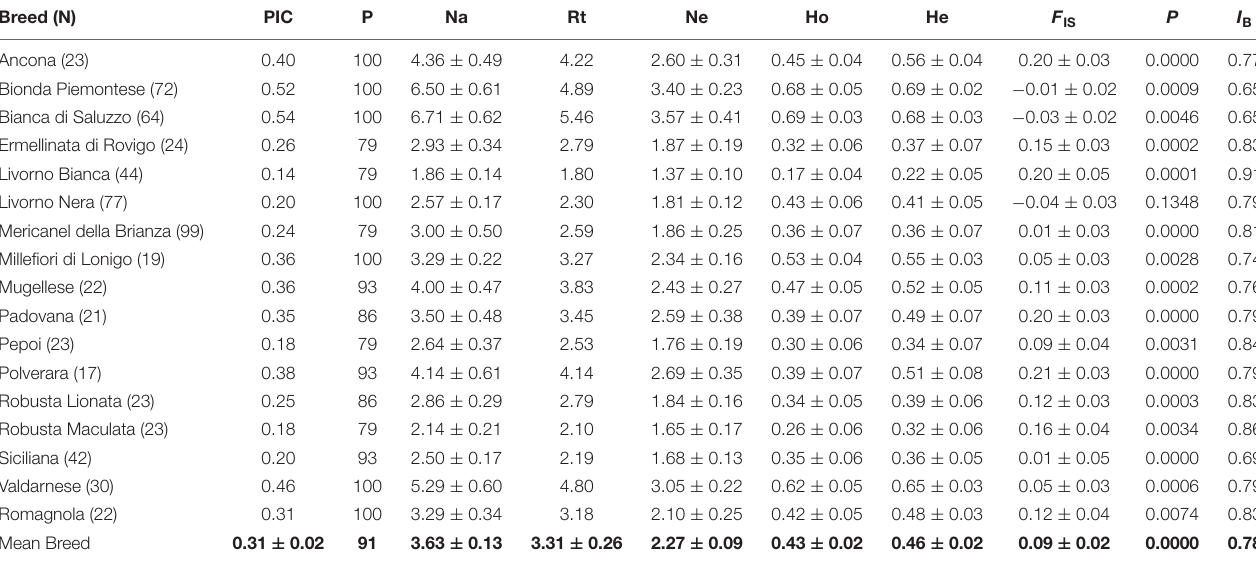
TABLE 1 | Breed genetic variability parameters. Breed (N) PIC P